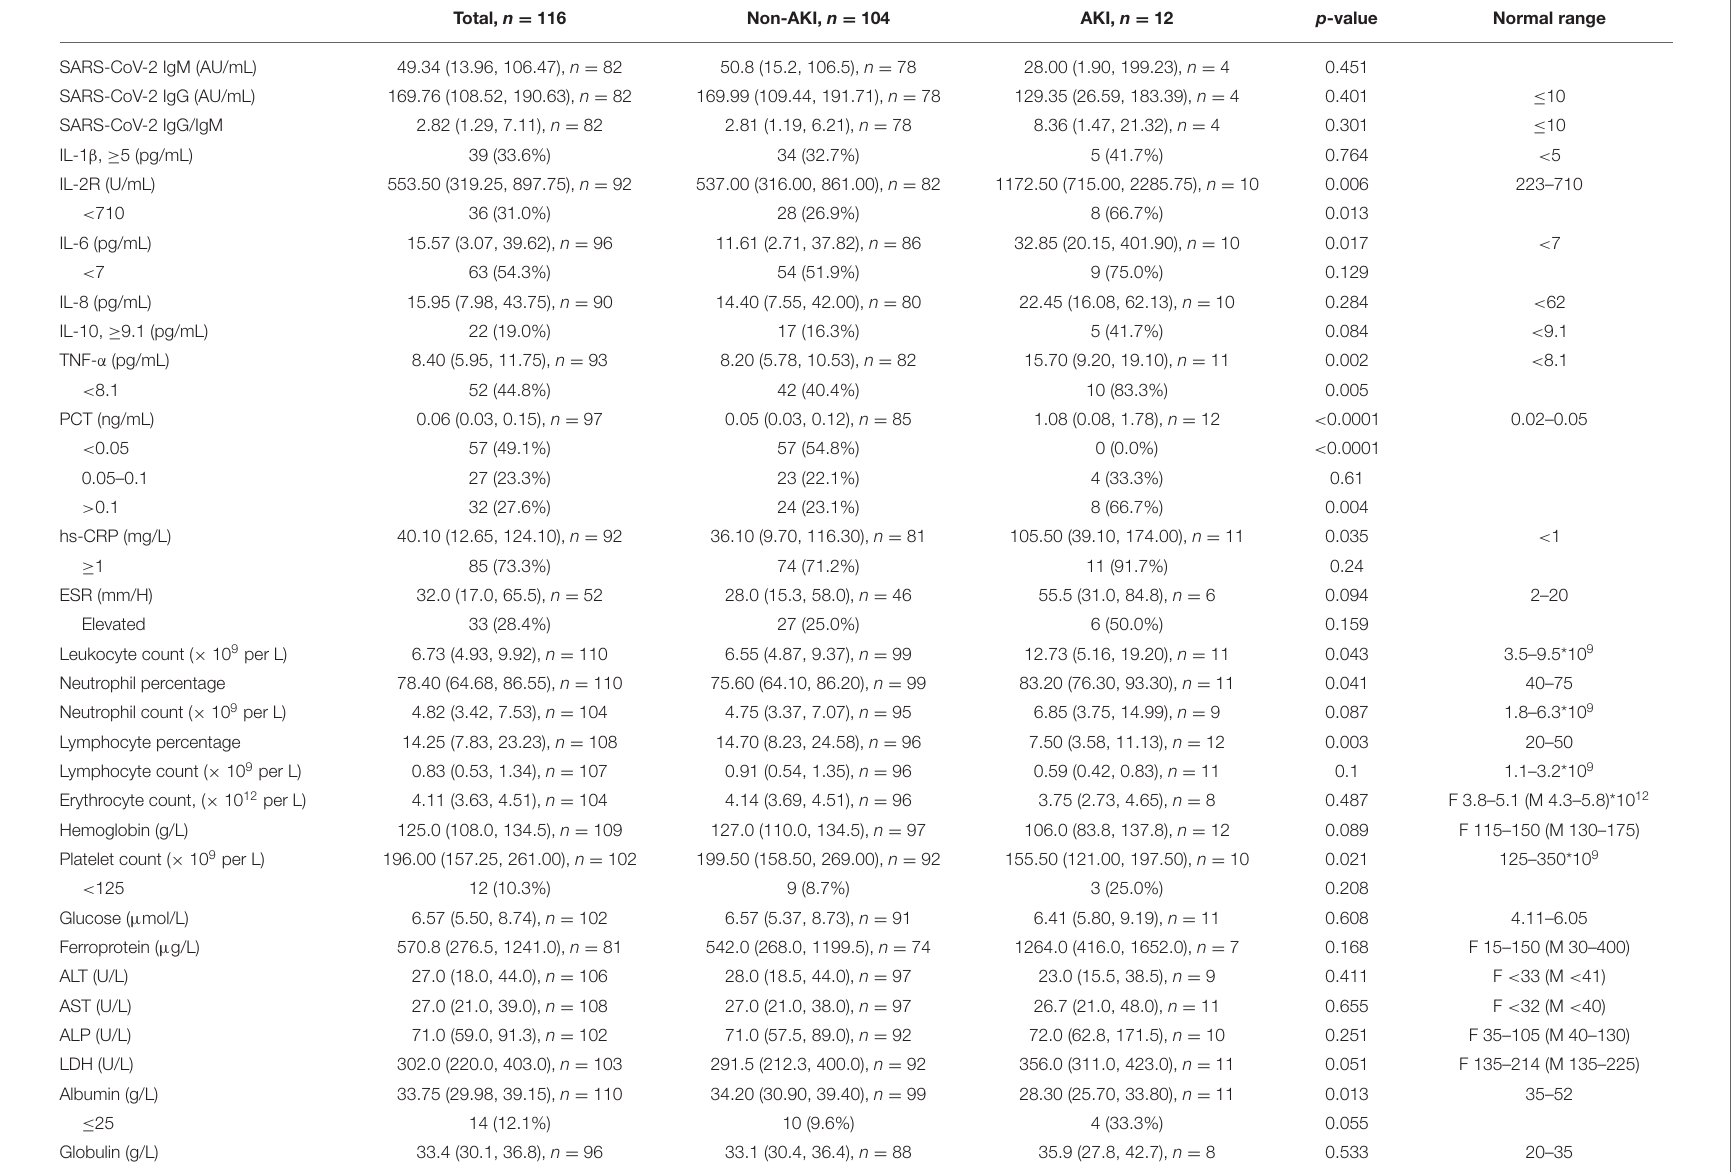
TABLE 2 | Laboratory and radiographic findings of the patients on admission. Total, n = 116 Non-AKI, n =